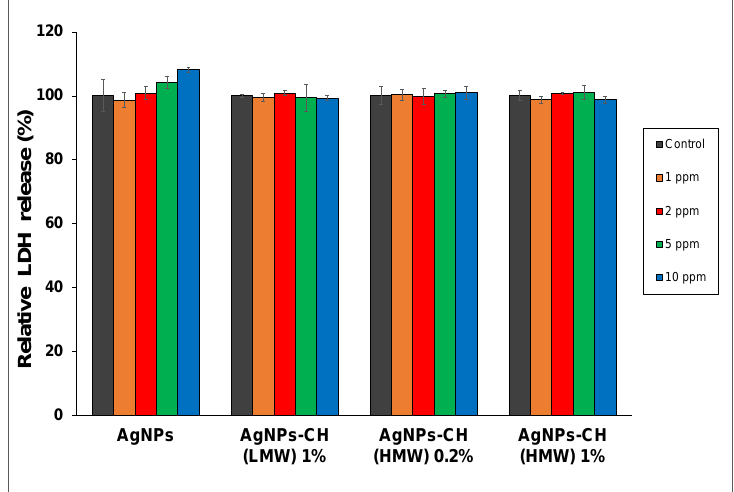
Figure 6. The lactate dehydrogenase (LDH) released in normal fibroblast cells, CCD-1070 Sk, treated with different concentrations of AgNPs after 24 h. The values are the means of the results for each sample from three separate experiments. Error bars indicate standard errors of the means.